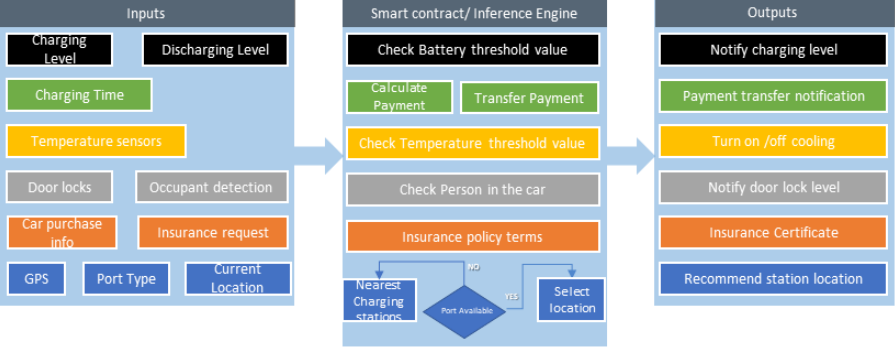
Figure 3. Data flow with inference